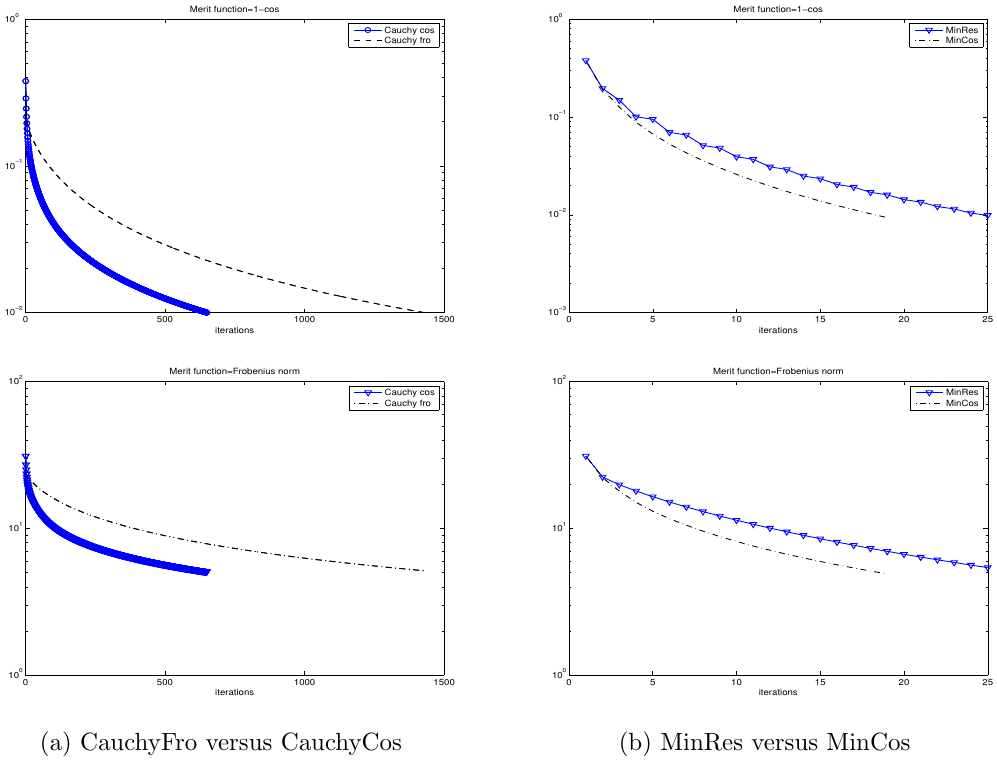
Figure 1: Convergence history for CauchyFro and CauchyCos (left), and MinRes and Figure 1. Convergence history for CauchyFro and CauchyCos ( left ), and MinRes and MinCos ( right ) MinCos (right) for two merit functions: F ( X ) (up) and Φ( X ) (down), when applied to for two merit functions: F ( X ) ( up ) and Φ ( X ) ( down ), when applied to the Wathen matrix for n = 20 the Wathen matrix for n = 20 and (cid:15) = 0 . 01. and (cid:101) =